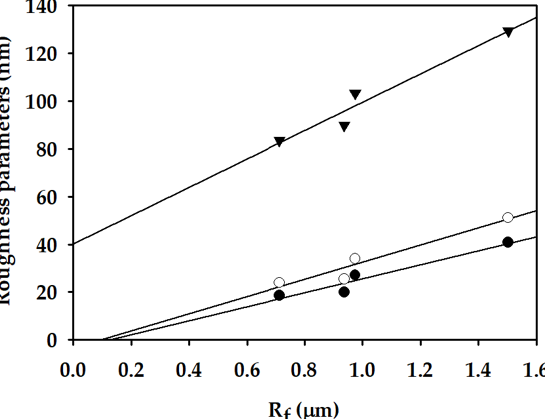
Figure 13. Roughness parameters versus Fiber radius of fabricated membranes (●: arithmetical mean deviation ( R a ); ○ : root mean square deviation ( R q ); ▼ : vertical distance between highest peak and lowest valley ( R max ).